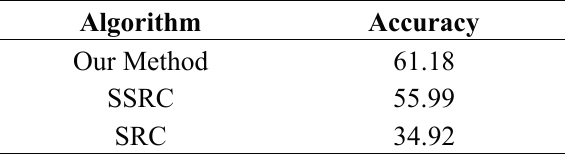
Table 4. Comparative recognition rates of our method and other recognition methods on the AR Database using a single training sample per